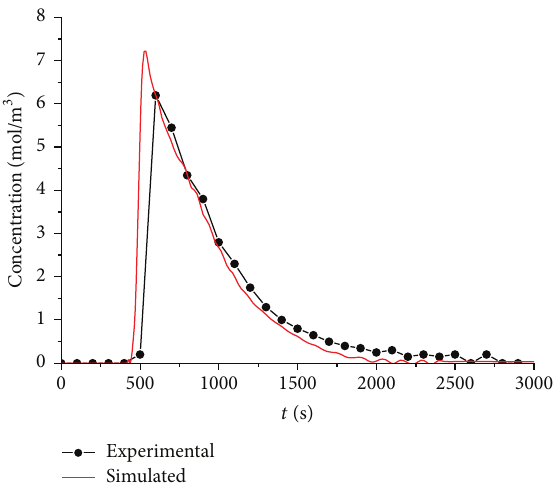
Figure 2: Verification of the integrated hydrodynamic and mass transfer models.